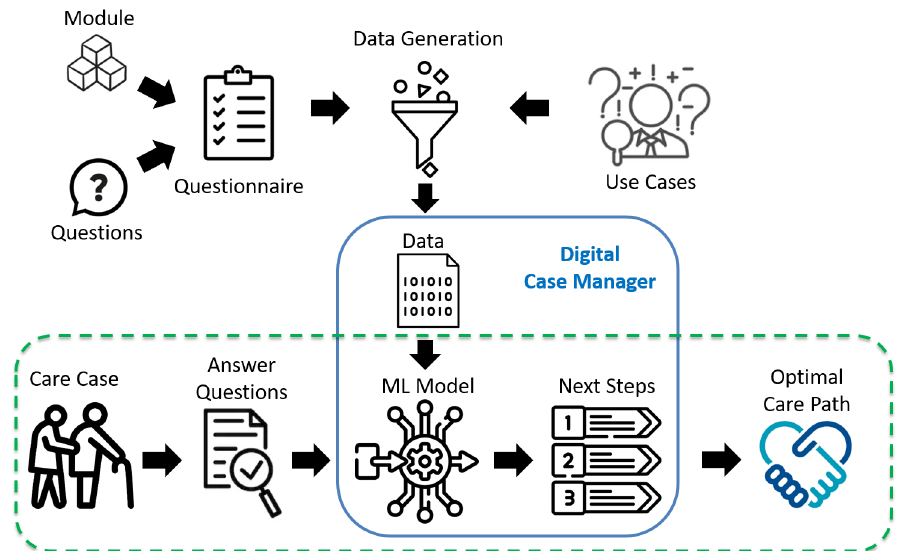
Figure 1. Concept of Digital Case Manager. A dashed line indicates the workflow of the Digital Case Manager application.